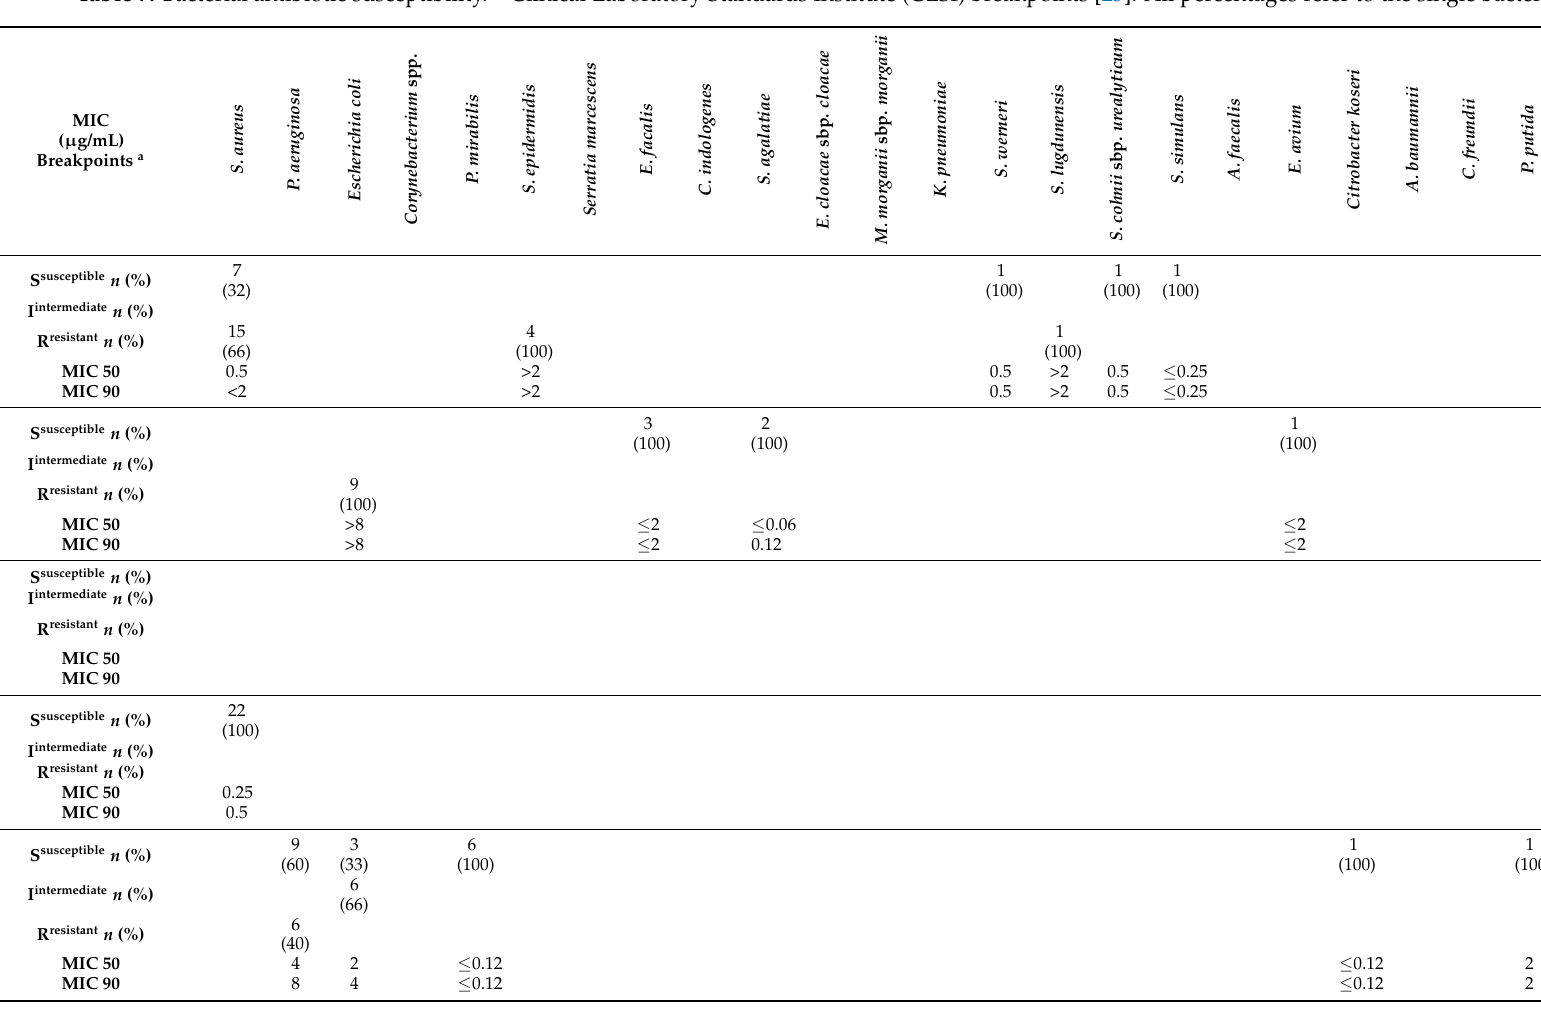
Table 7. Bacterial antibiotic susceptibility. a Clinical Laboratory Standards Institute (CLSI) breakpoints [25]. All percentages refer to the single bacterial specie